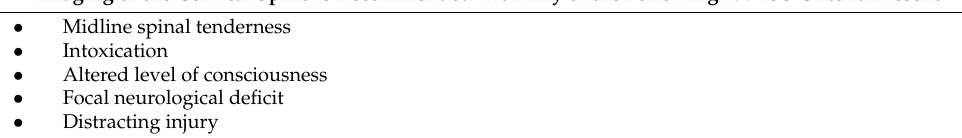
Table 1. NEXUS criteria.